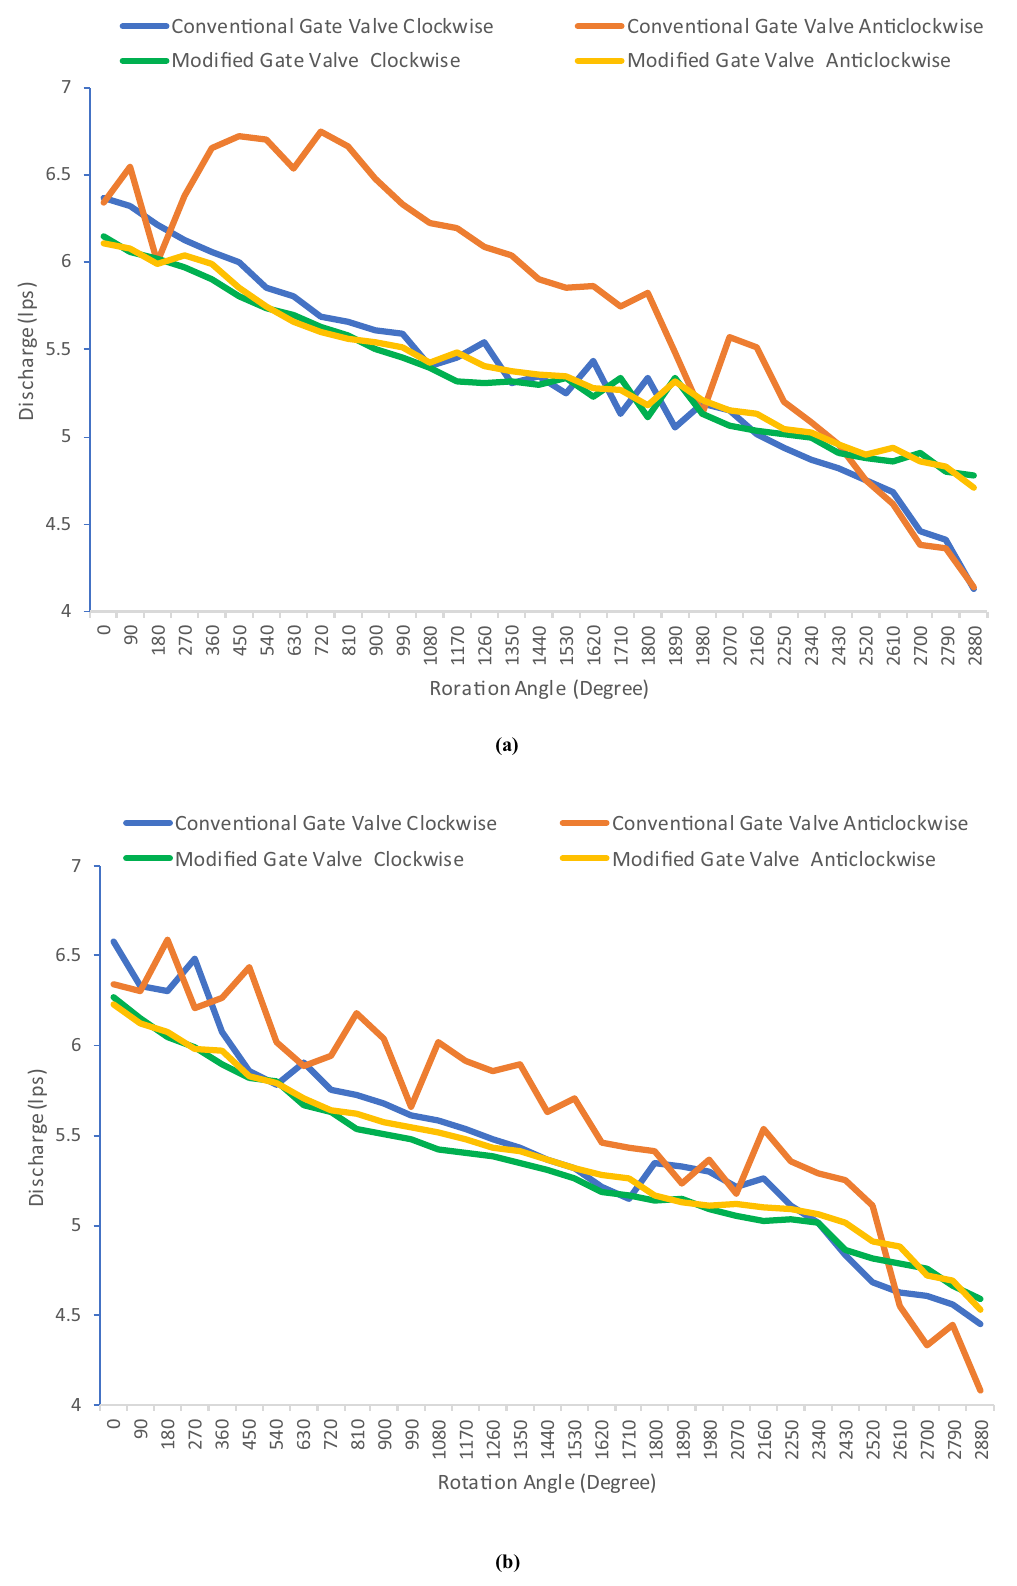
Fig. 7 Comparison of discharge through conventional and modified gate valve for both cases in clockwise and anticlockwise